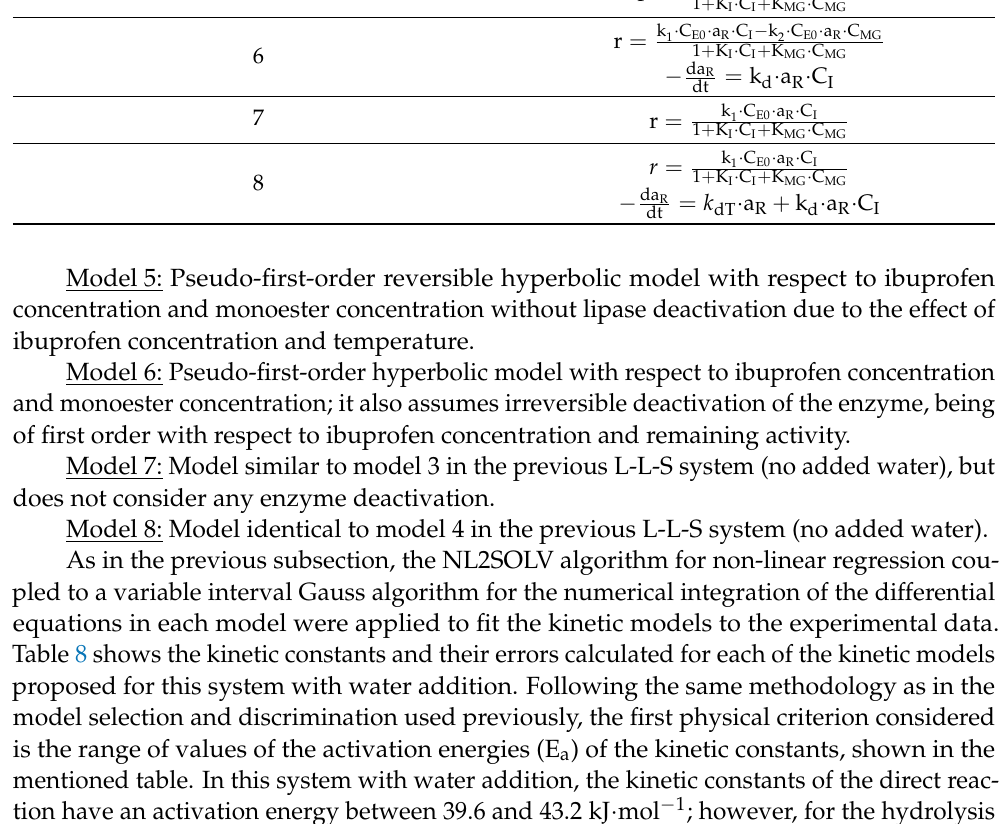
Table 7. Kinetic equations corresponding to the proposed kinetic models to fit all data from the triphasic L-L-S system composed of glycerol(+water)-toluene(+ibuprofen)-N435. Model